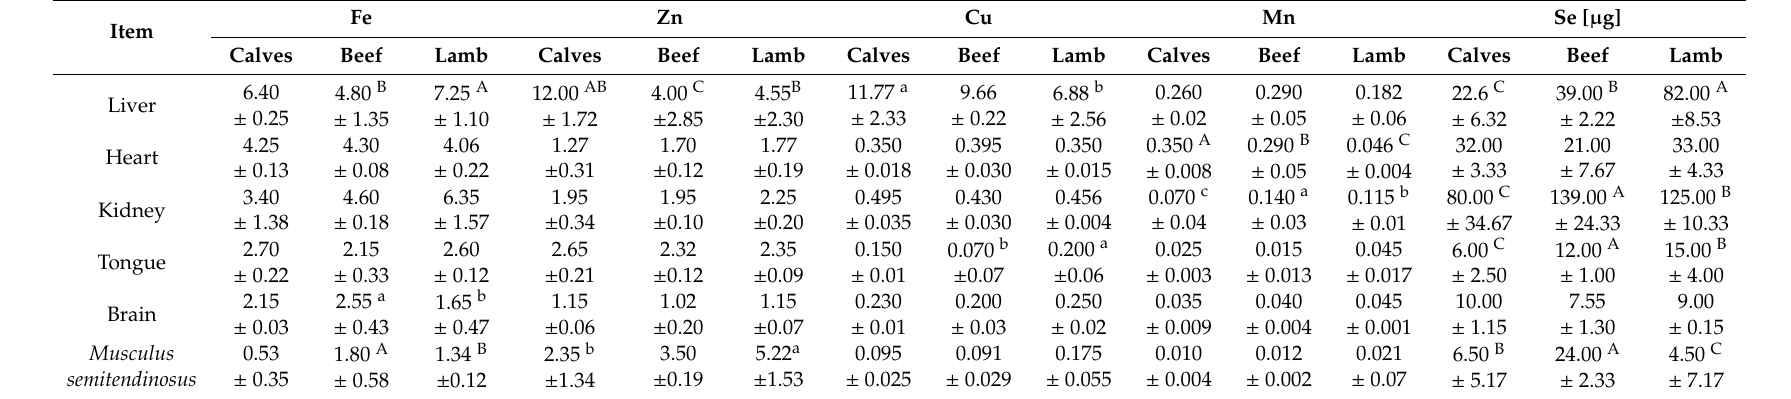
Table 3. Micronutrients in the tested organs (mg / 100